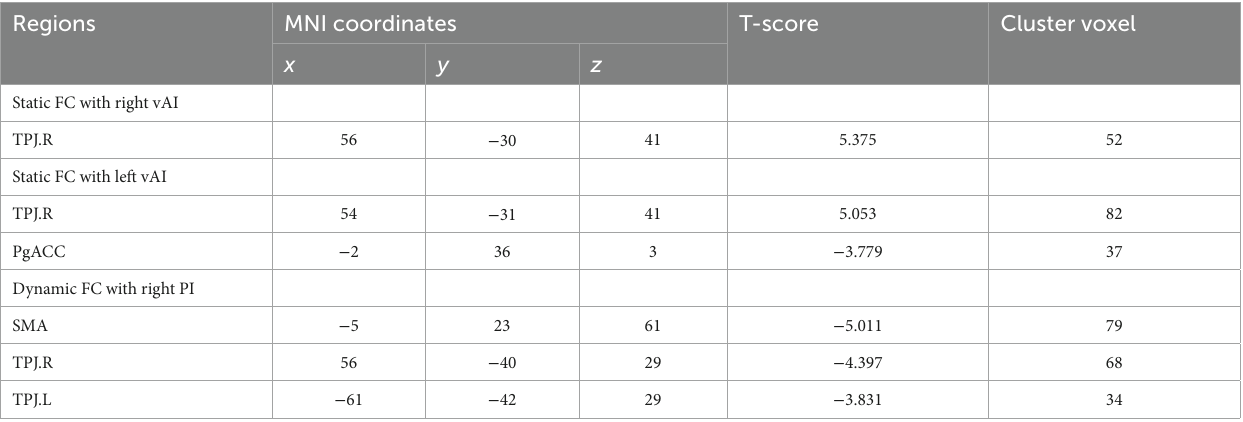
TABLE 2 Significant static and dynamic functional